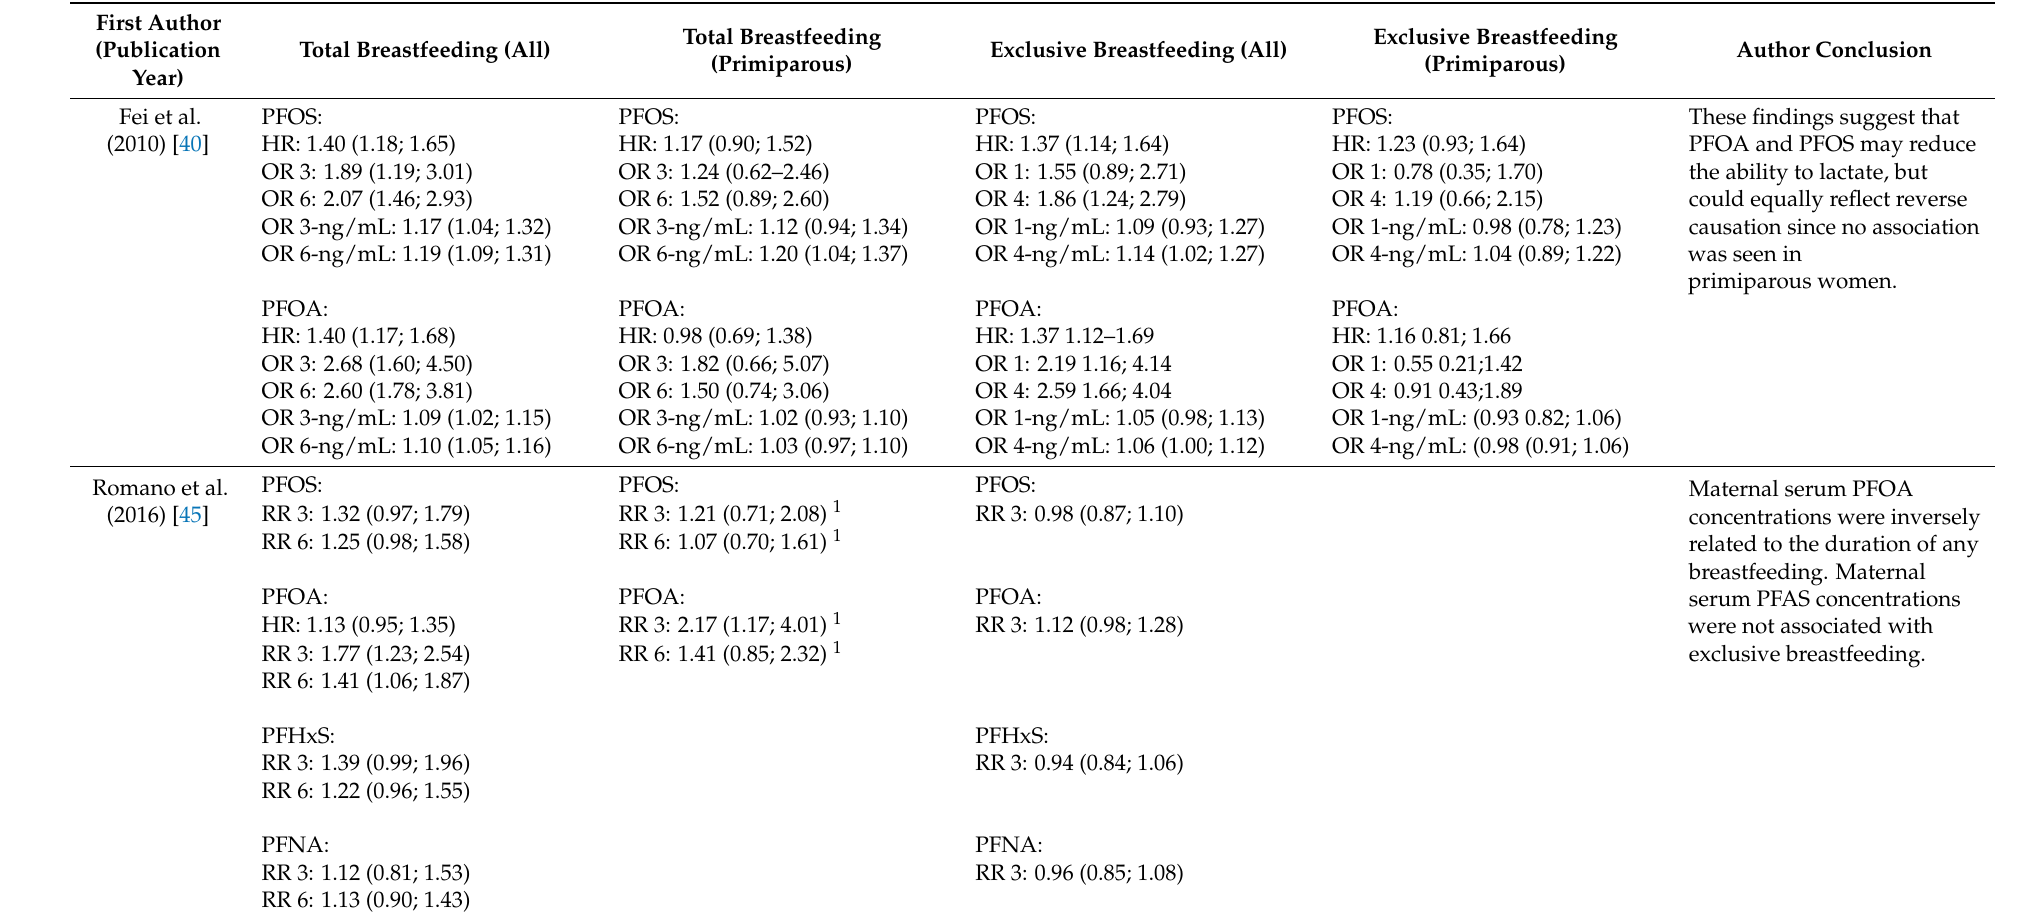
Table 6. Summary of study